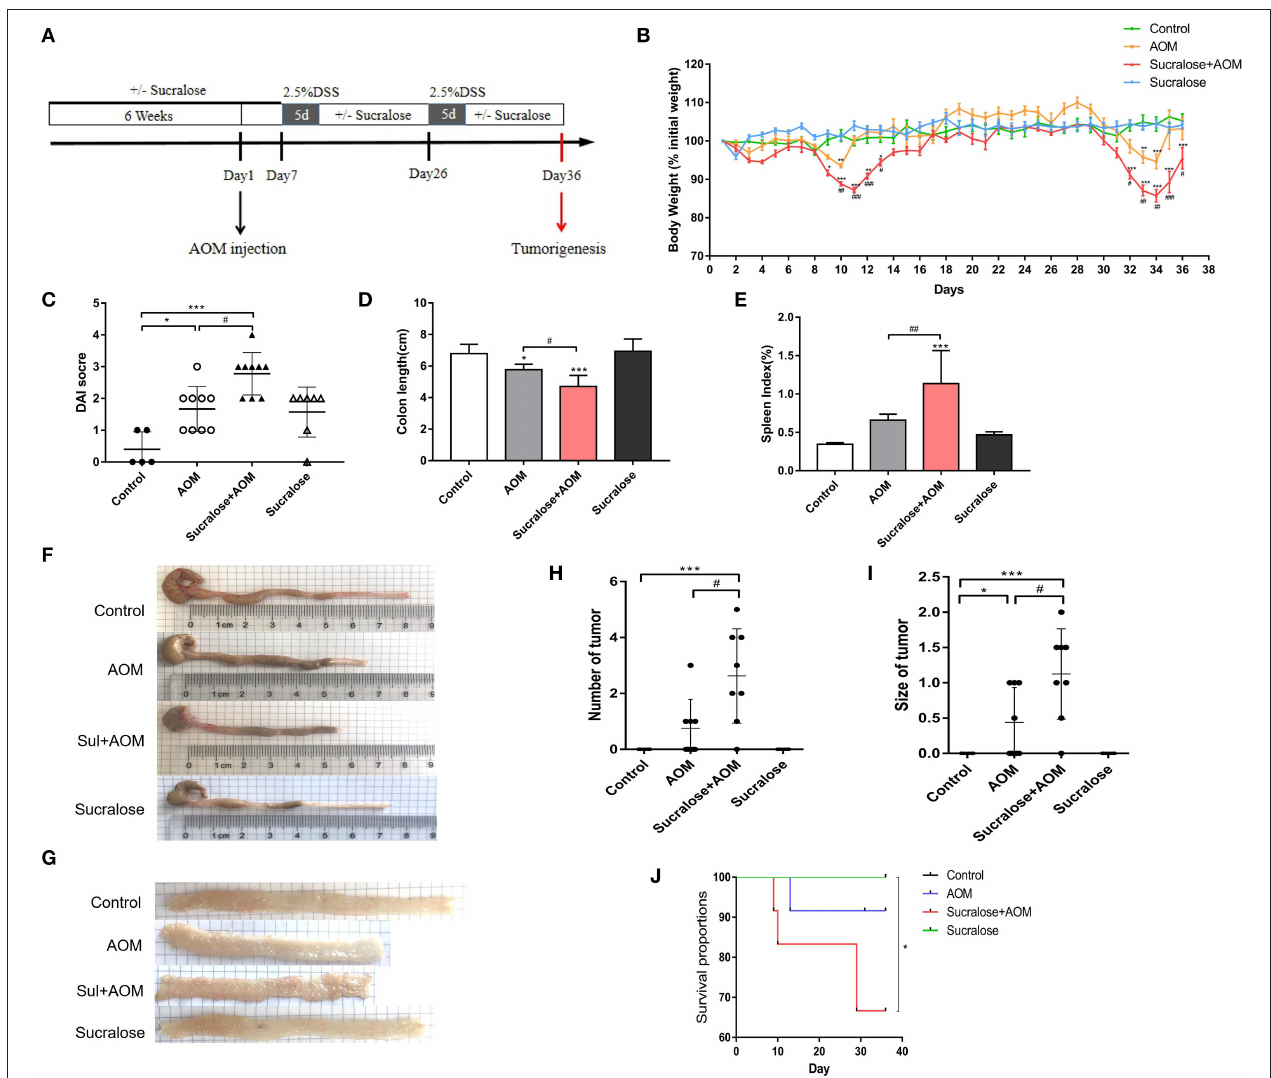
FIGURE 1 | Sucralose significantly increases the severity of disease of AOM/DSS colon cancer mice. (A) Protocol of sucralose and AOM/DSS treatments used in this study. (B) Change in body weight, (C) disease activity index (DAI) score, (D) colon length, (E) spleen weight index, (F) photoraphs showing colon length, (G) photograph of colon tumor, (H) tumor number, (I) tumor size, and (J) survival rate. Compared with the control group: * P < 0.05, ** P < 0.01, *** P < 0.001; compared with the AOM group: # P < 0.05, ## P < 0.01, ### P < 0.001, n =